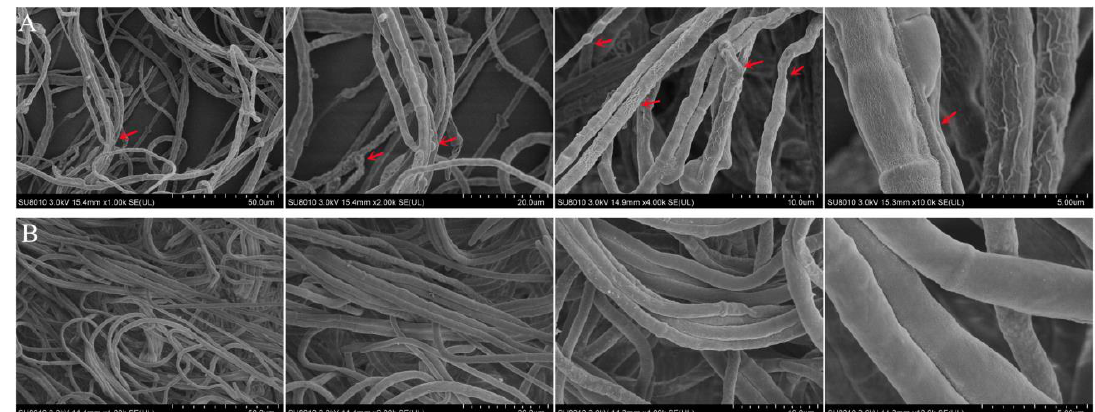
Figure 9. Scanning electron micrograph analysis of A. alternata mycelia ultrastructure morphology.